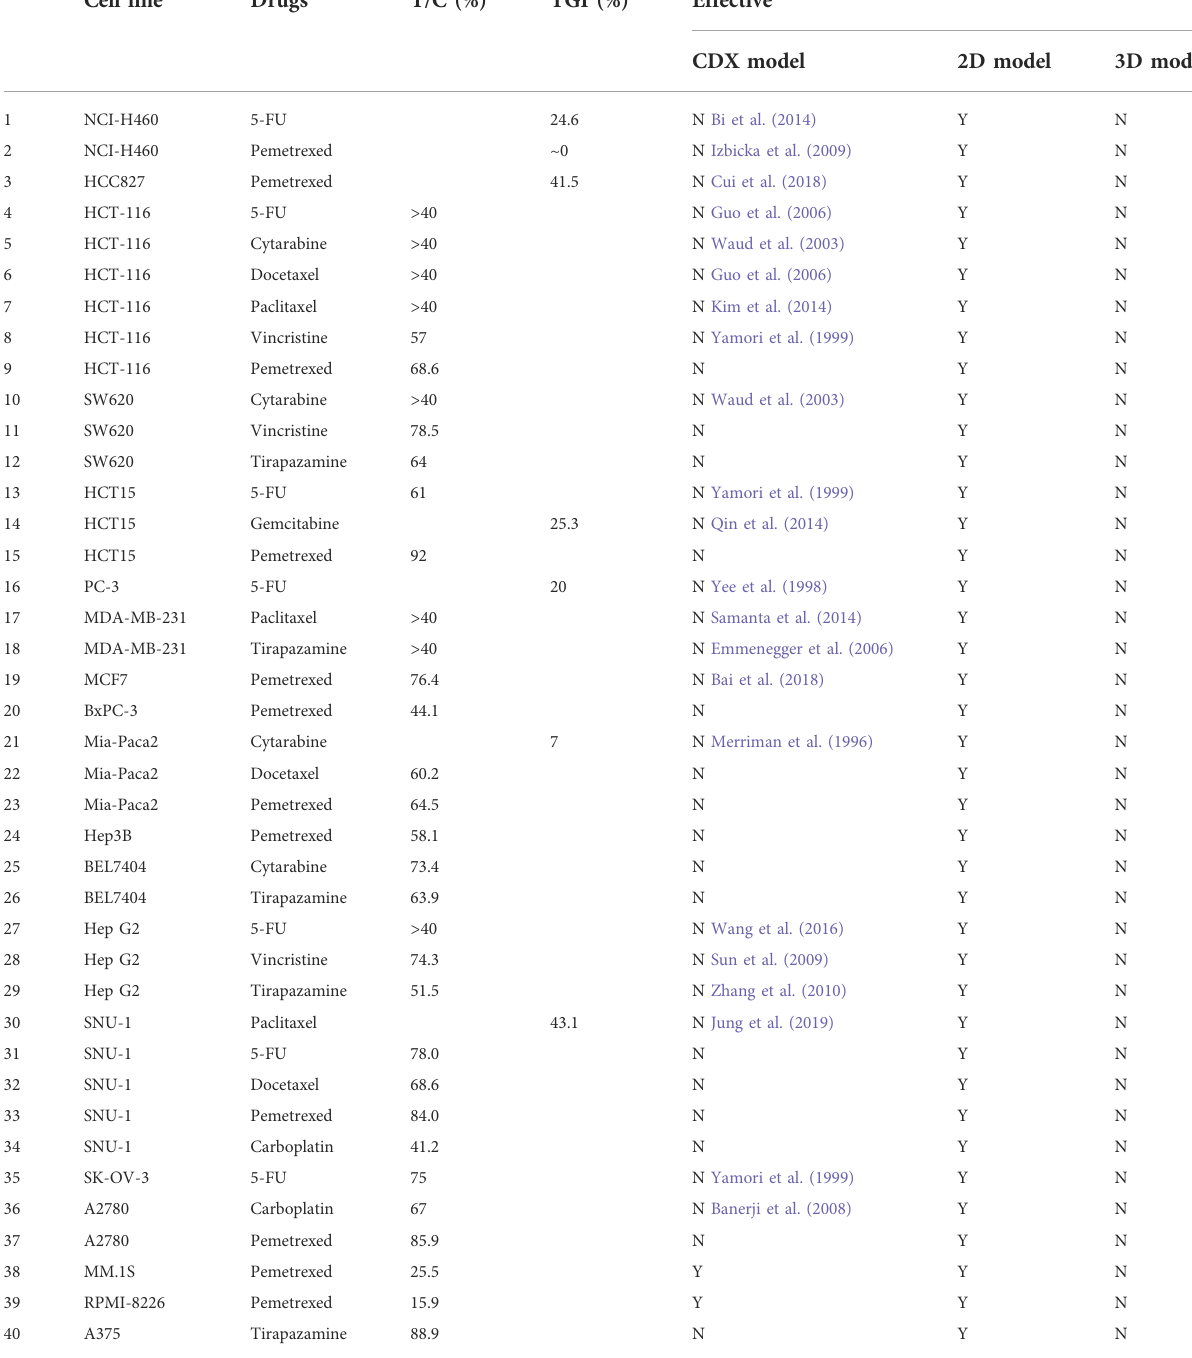
TABLE 1 In vivo T/C or TGI values and the evaluation results from three